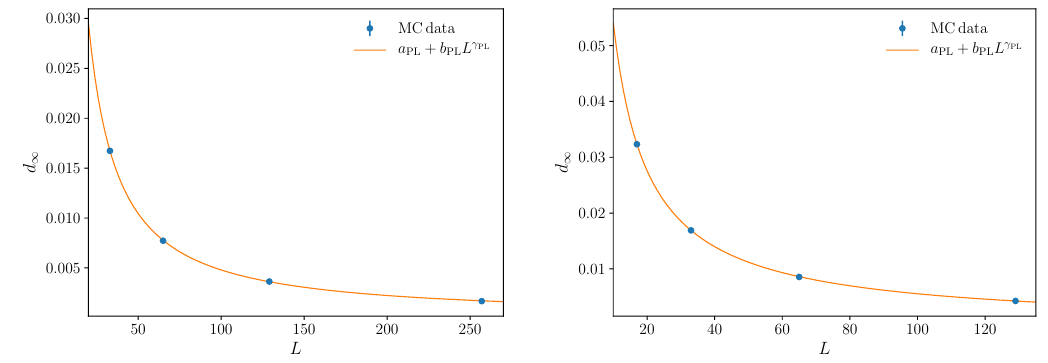
Figure 8 . Distance d 1 (see eq. (5.3)) between the measured R MC function of L for Q = 2 (left) and Q = 3 (right). The data can be (cid:12)tted with a power law function a PL + b PL L (cid:13) PL with a PL = (1 : 0